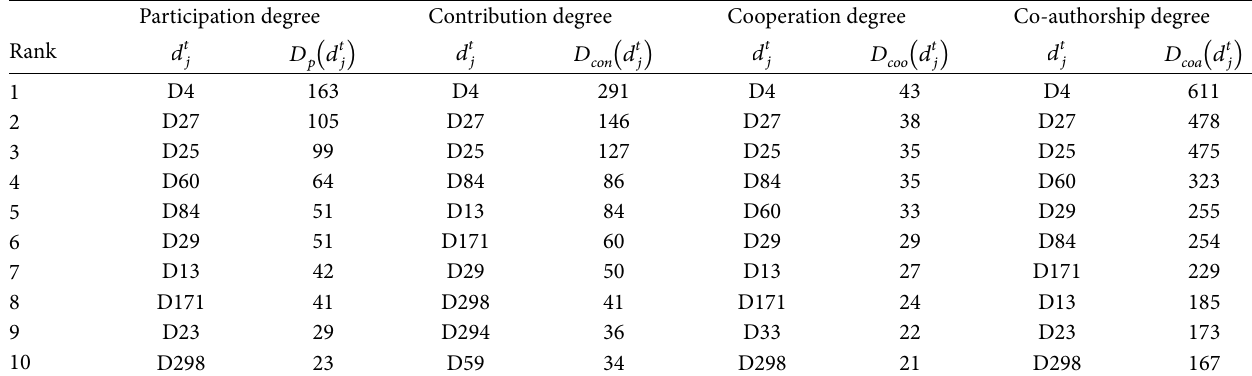
8: The top ten drafters with high indicators in WCDMA